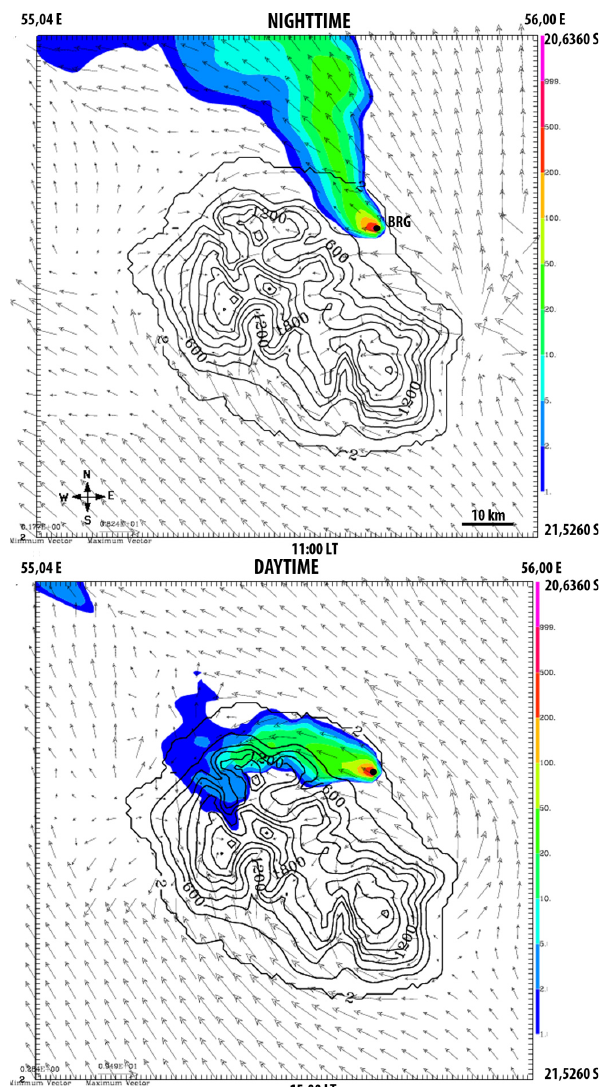
Fig. 12. ALIZ5 – horizontal field of the tracer dilution ratio (per mil of the concentration at emission point) at the first model level above the ground, emitted from POR, at 07:00LT (top) and 14:00LT (bot- tom).